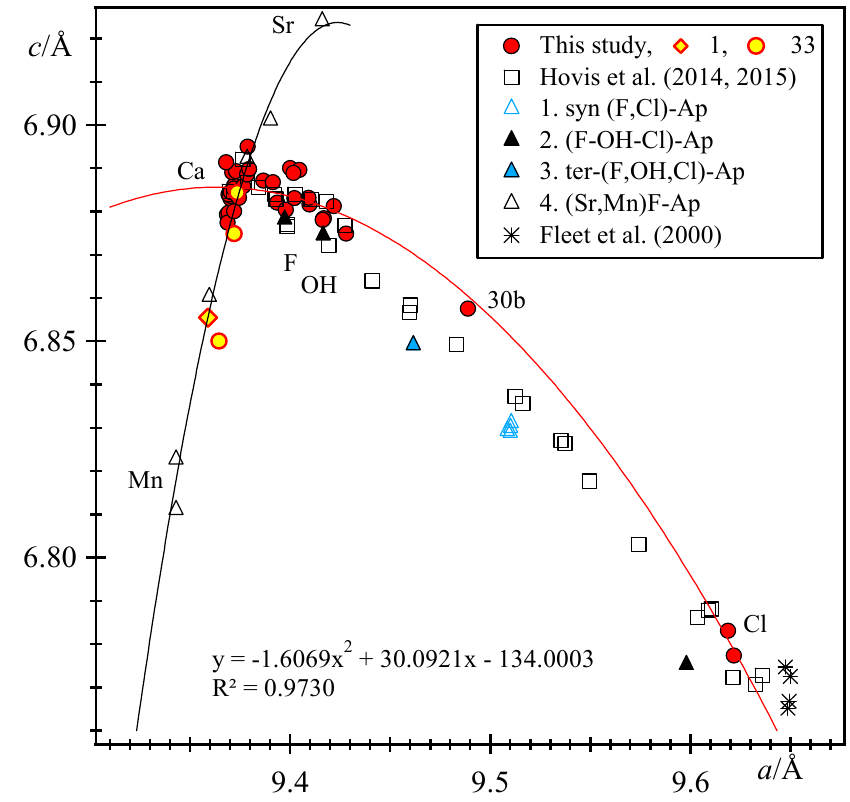
Figure 9. Variation of the unit-cell parameters a with c across natural Ap solid solutions. The red trend line (equation inserted) is based on the data from this study (red circles). Data from the literature plots close to the red trend line. Sample-30b, which is a (OH,Cl)-rich Ap, has a V that plots about midway between OH-Ap and Cl-Ap. Group-4 samples (black open triangles) are for (Sr,Mn)F-Ap and these give rise to the black trend line. Our samples-1 and -33 (yellow symbols) fall close to the black trend line, so these are not included in the red-trend line computation.